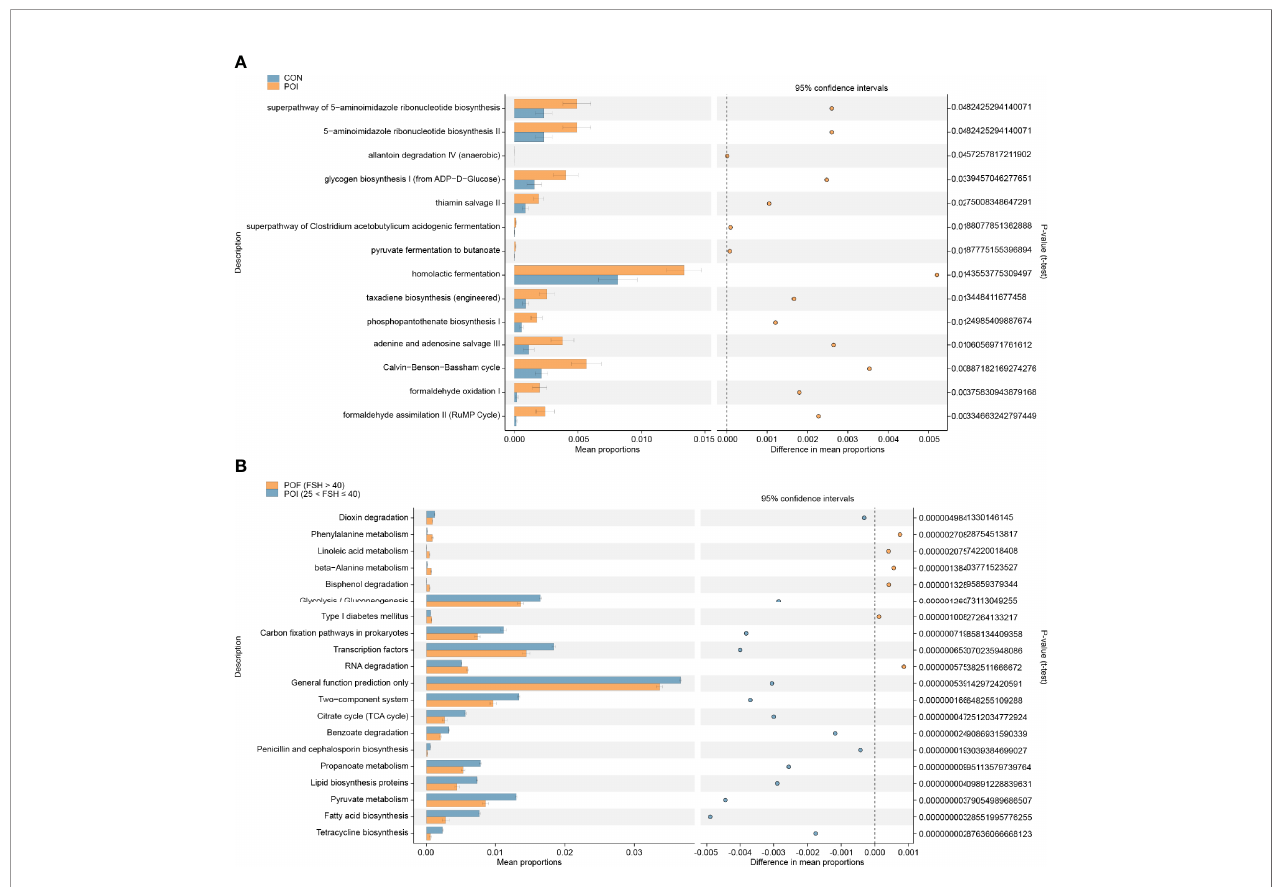
FIGURE 3 | Analyze and predict the metabolic functions of vaginal microbiota by the PICRUSt2 method. (A) Signi fi cantly different pathways between the POI and the control groups. (B) Top 20 signi fi cantly different pathways between the POI (25 < FSH ≤ 40) and POF (FSH > 40) subgroups. PICRUSt, phylogenetic investigation of communities by reconstruction of unobserved states. P < 0.05 was considered statistically signi fi